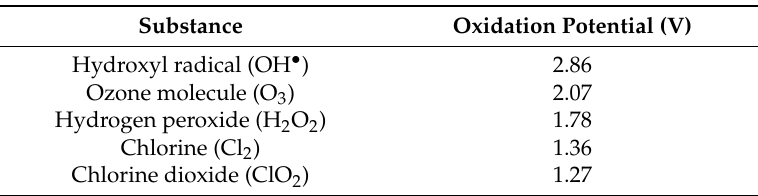
Table 2. The oxidation potential of some reactive